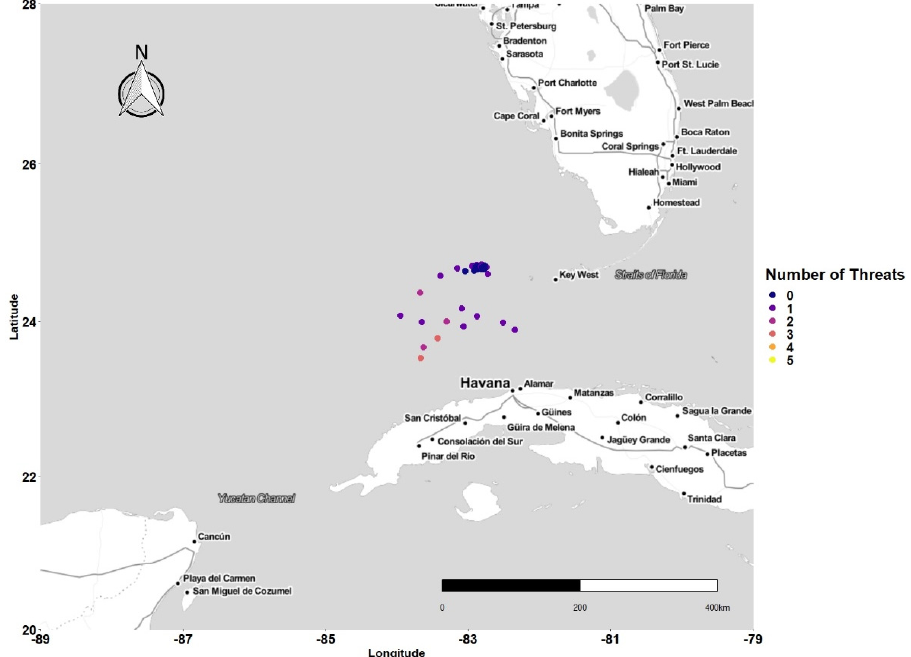
Figure A2. State-space model (SSM) points of Turtle #4, a green turtle ( Chelonia mydas ) that conducted migratory movements from and then promptly returned to Dry Tortugas National Park between 2 June and 18 June 2017. Each color represents the number of unique high threat categories encountered on that given day within a 2 km buffer of the SSM point.